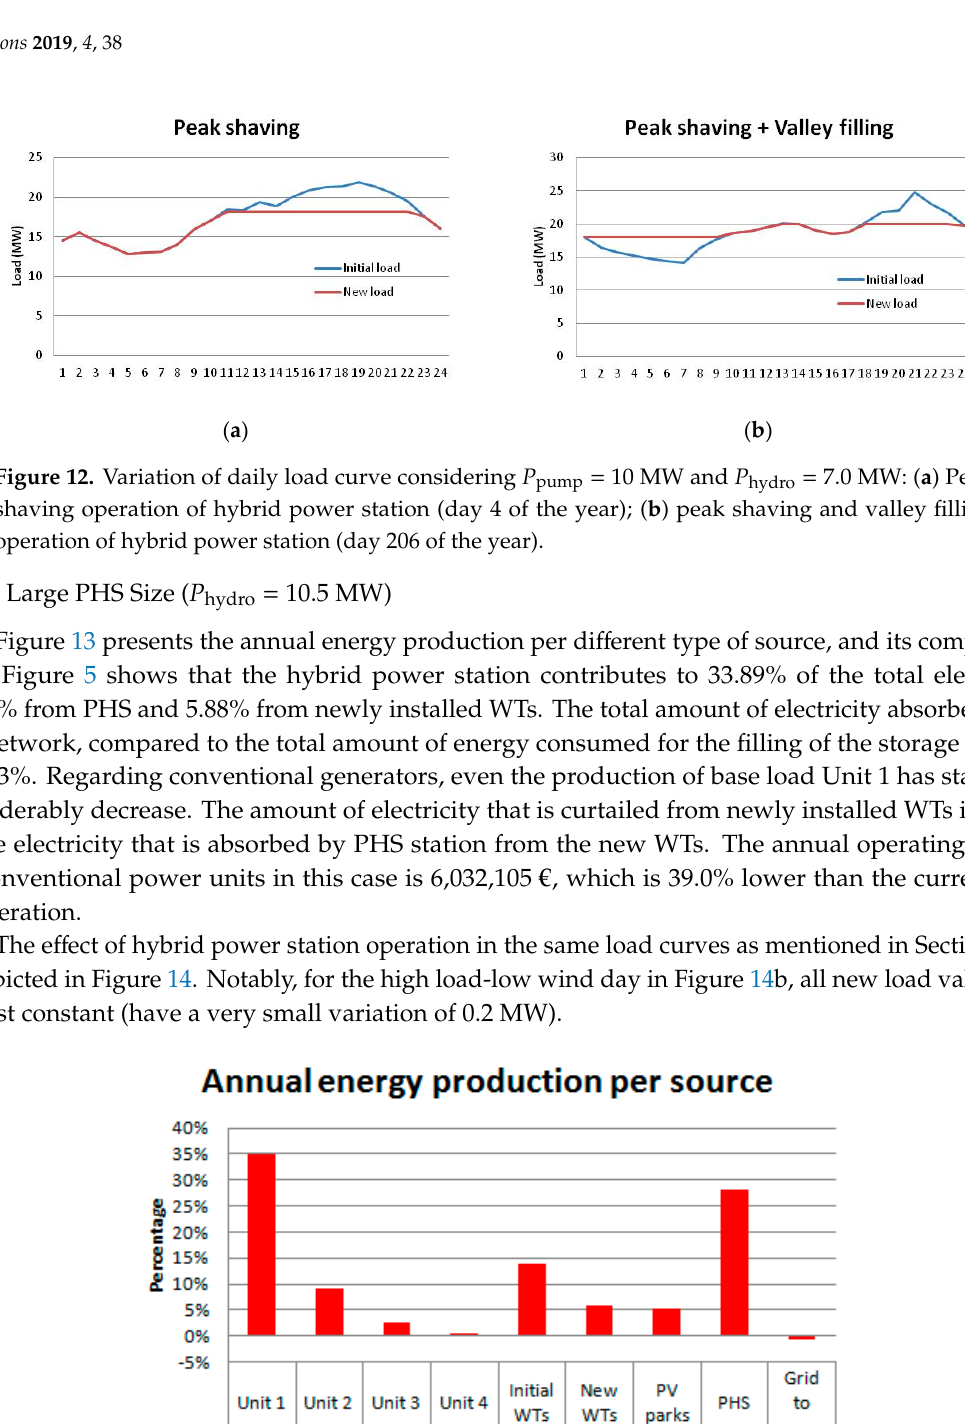
Figure 11. Annual energy production in Samos Island from different sources, considering hybrid power station operation ( P hydro = 7.0 MW).